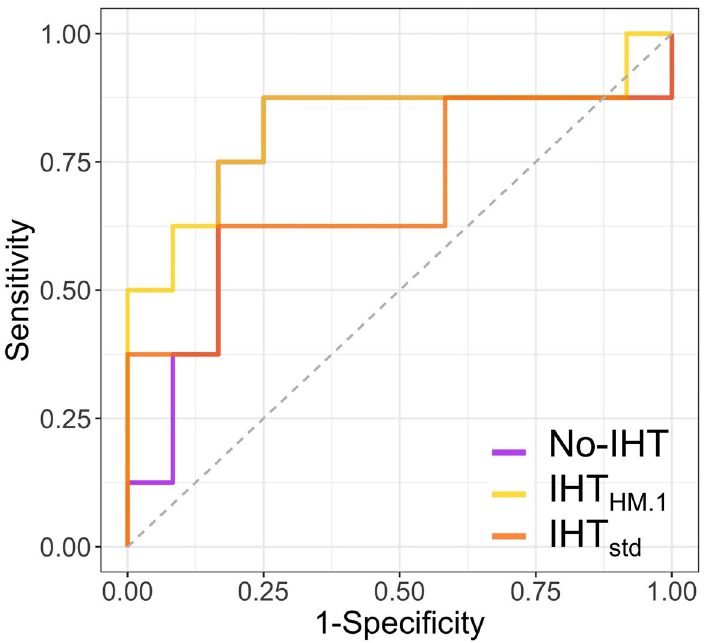
Figure 5. ROC curves for the best and worse supervised models to predict metastatic relapse within 2 years after the end of initial treatment in the testing cohort (built on the radiomics features from the IHT HM.1 and IHT std datasets, respectively). The ROC curve of the final model without using harmonization technique (No-IHT) is also shown for